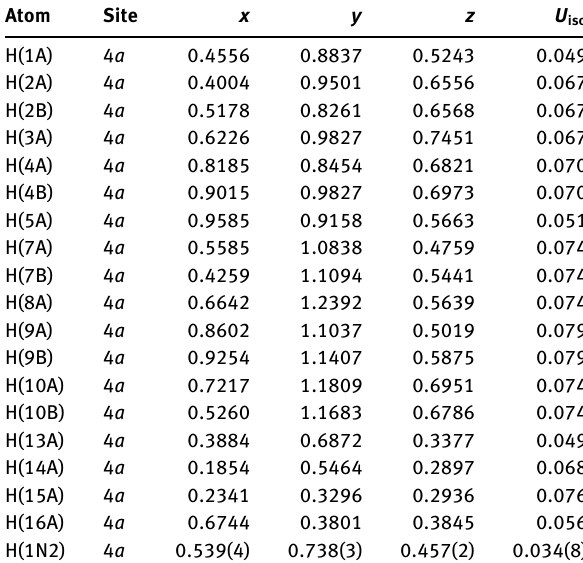
Table 2: Fractional atomic coordinates and isotropic or equivalent isotropic displacement parameters (Å 2